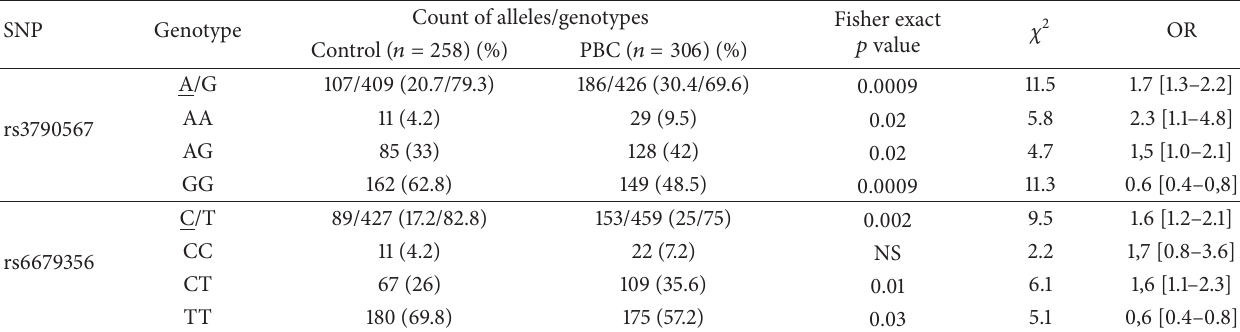
Table 2: Distribution of IL12RB2 polymorphisms (rs3790567, rs6679356) in PBC patients and control